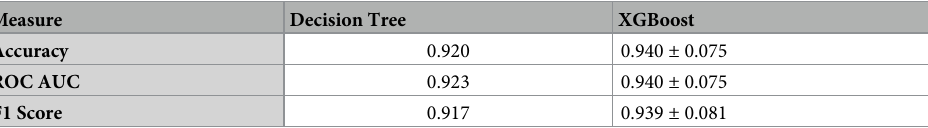
Table 2. [Iris dataset] model performance